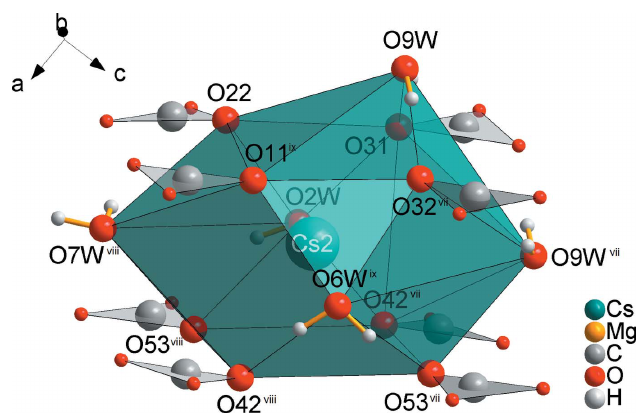
Figure 6 Coordination sphere of the Cs2 cation, with all atoms drawn as spheres of arbitrary radii (oxygen atoms not coordinating to Cs with half of the size of other O atoms). [Symmetry codes: (vii) (cid:4) x + 2, (cid:4) y + 1, (cid:4) z + 1; (viii) x + 1, y , z ; (ix) (cid:4) x + 3, (cid:4) y + 1, - z. ]